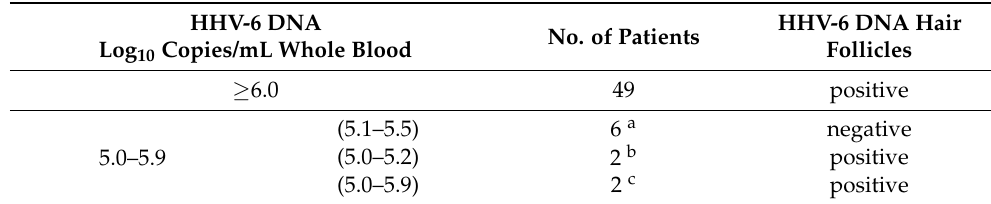
Table 1. Identification of iciHHV-6 status among the 59 patients with a viral load in blood ≥ 5.0 Log 10